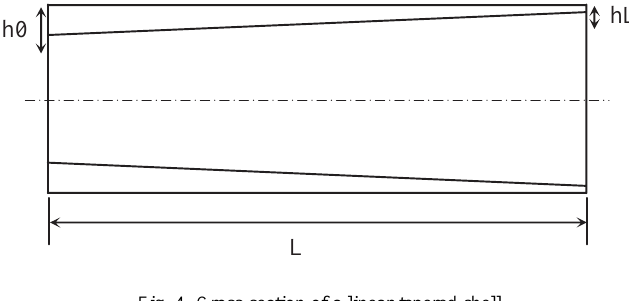
Fig. 4. Cross-section of a linear-tapered